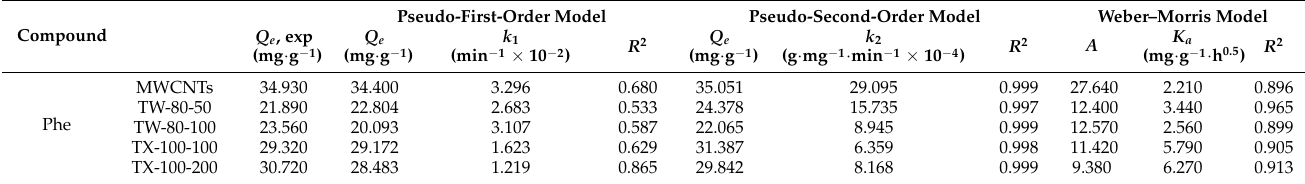
Table 2. Parameters of pseudo-first-order and pseudo-second-order model and Weber–Morris model for adsorption kinetics of Phe onto MWCNTs as affected by surfactants.